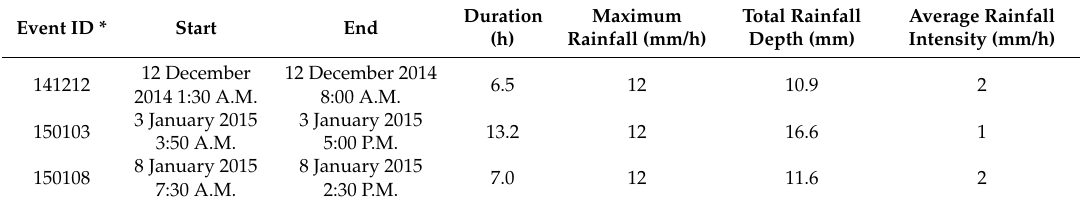
Table 1. Summary of rainfall records used for the Cranbrook case study.